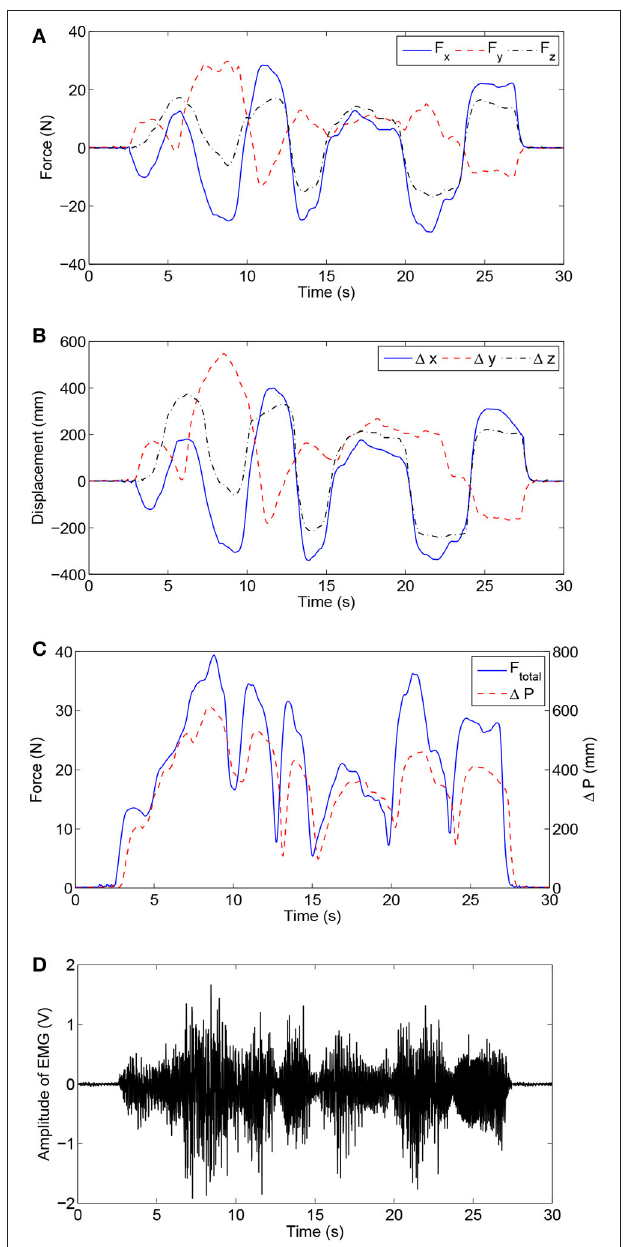
FIGURE 10 | Experimental results of virtual airplane-game operation training executed by healthy subject H1. (A) Interaction forces in different directions. (B) Position deviations in different directions. (C) Comparisons of the resultant interaction force and combined position deviation. (D) Time history of EMG activity levels of bicipital muscle.